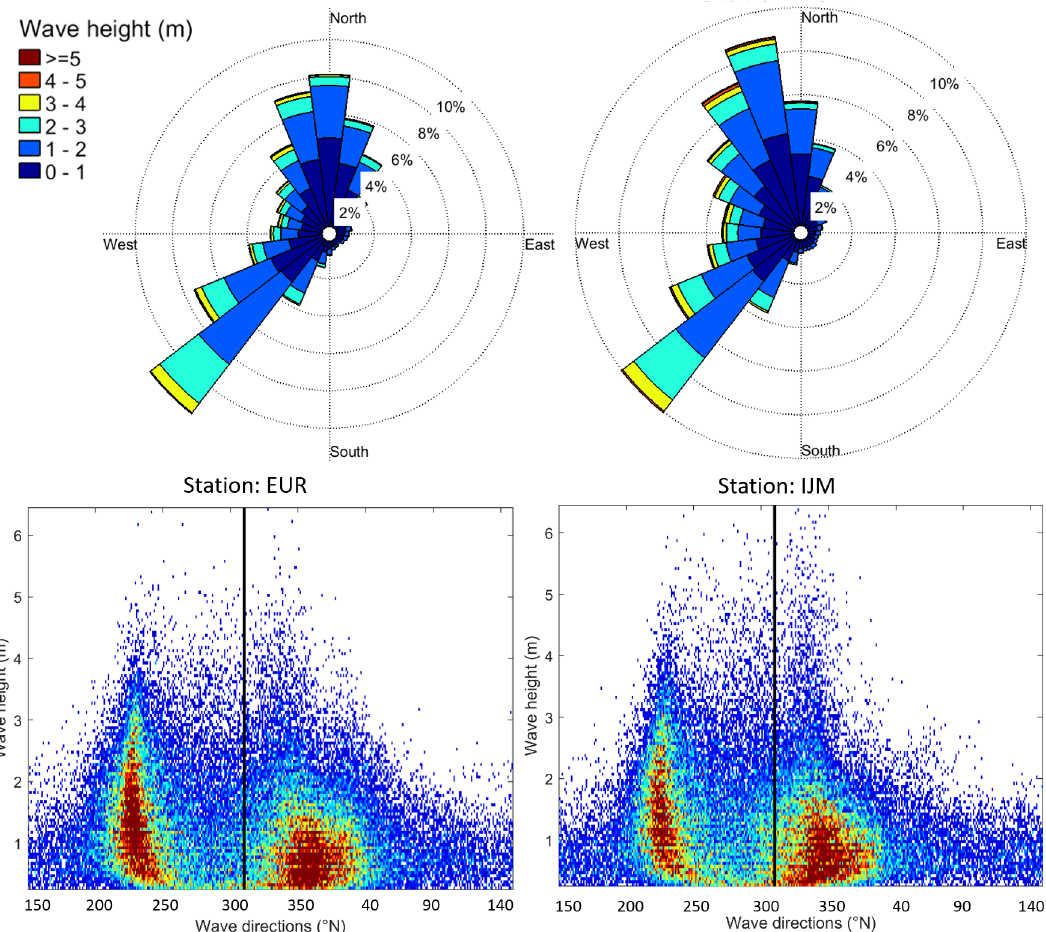
Figure 9. Wave rose and density distribution of wave height vs. direction for Europlatform (left) and IJmuiden (right). The black line at 311 ◦ N represents the angle of the shore normal at the ZM location prior to